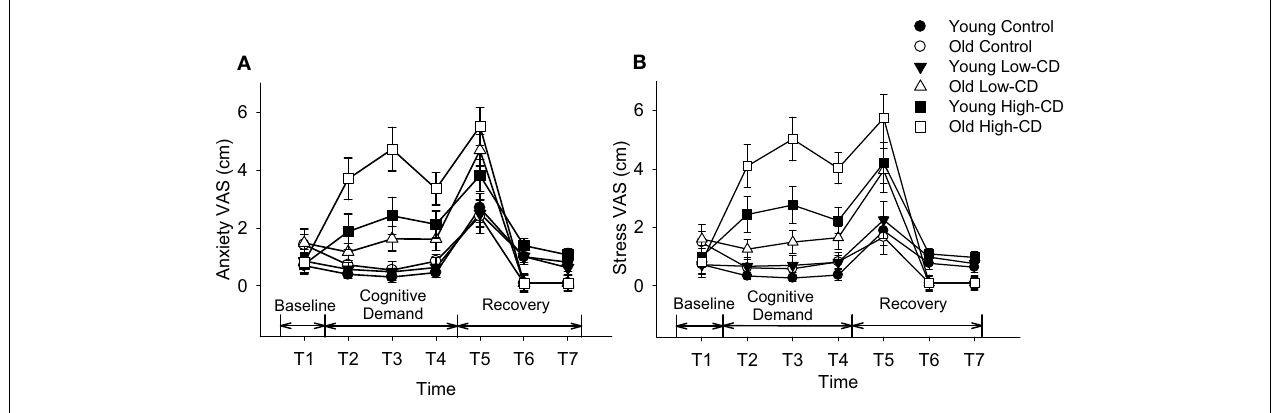
(High-CD, squares).Time intervals were as follows: baseline (T1), after the first bout of 2min of quiet rest/mental math (T2), after the second bout of 2min of quiet rest/mental math (T3), after the 5% submaximal contraction (T4), during recovery immediately after task failure (T5), and then at 5min (T6) and 10min of recovery (T7).